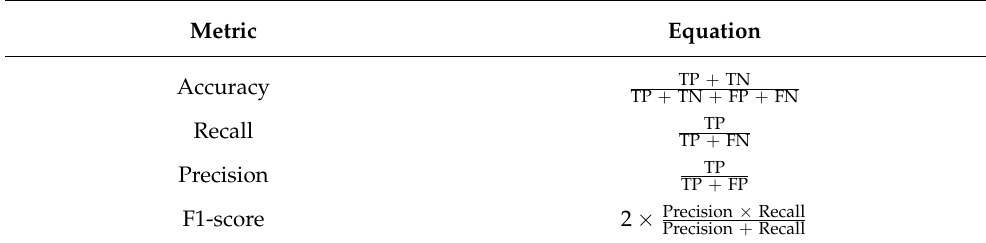
Table 1. Most commonly used metrics in HAR